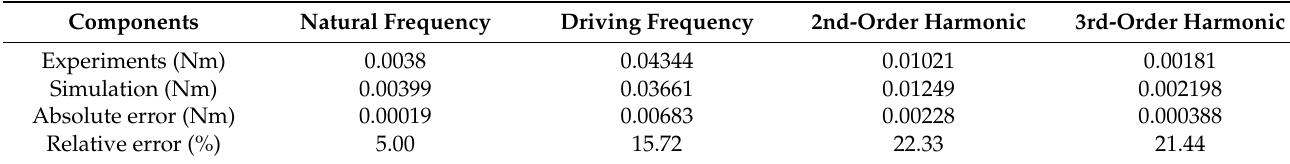
Table 6. Comparison of simulation/test